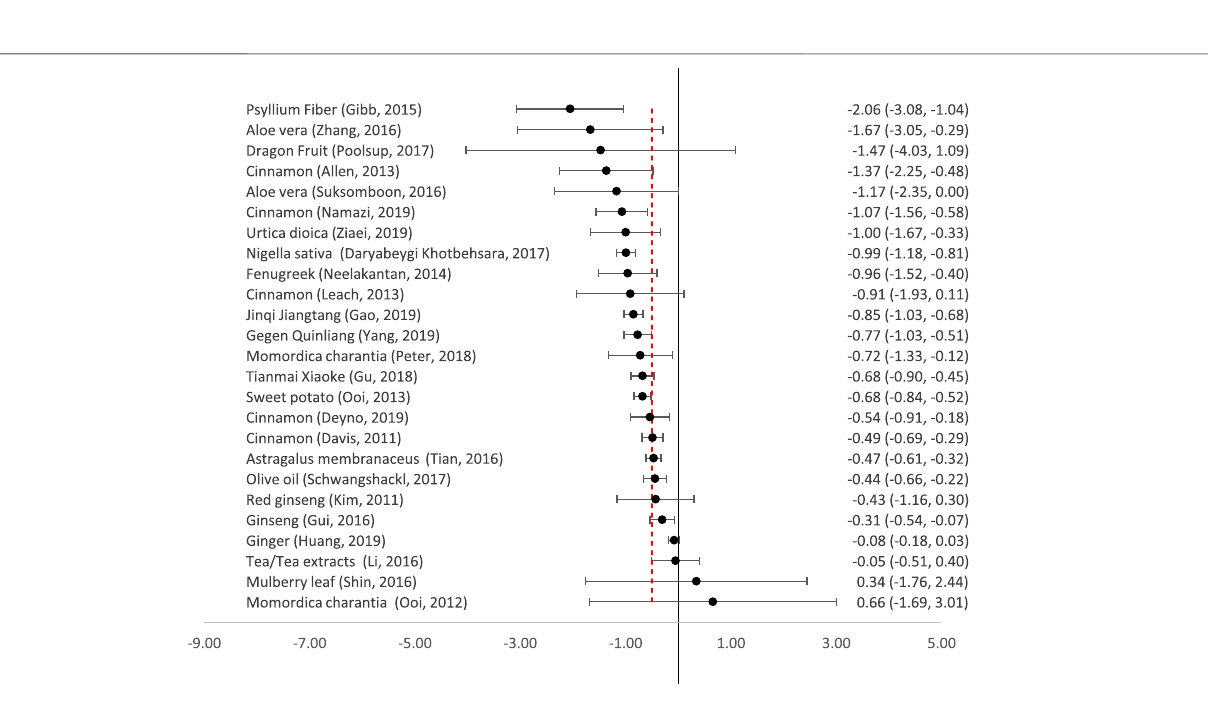
FIGURE 3 | Effect of medicinal plants on Fasting Plasma Glucose (mmol/l). The red dotted line indicates the threshold for a clinically signi fi cant effect (reduction by 0.5mmol/l). The point indicates the effect size, and the line (and fi gures to the right) indicate the 95% con fi dence interval.